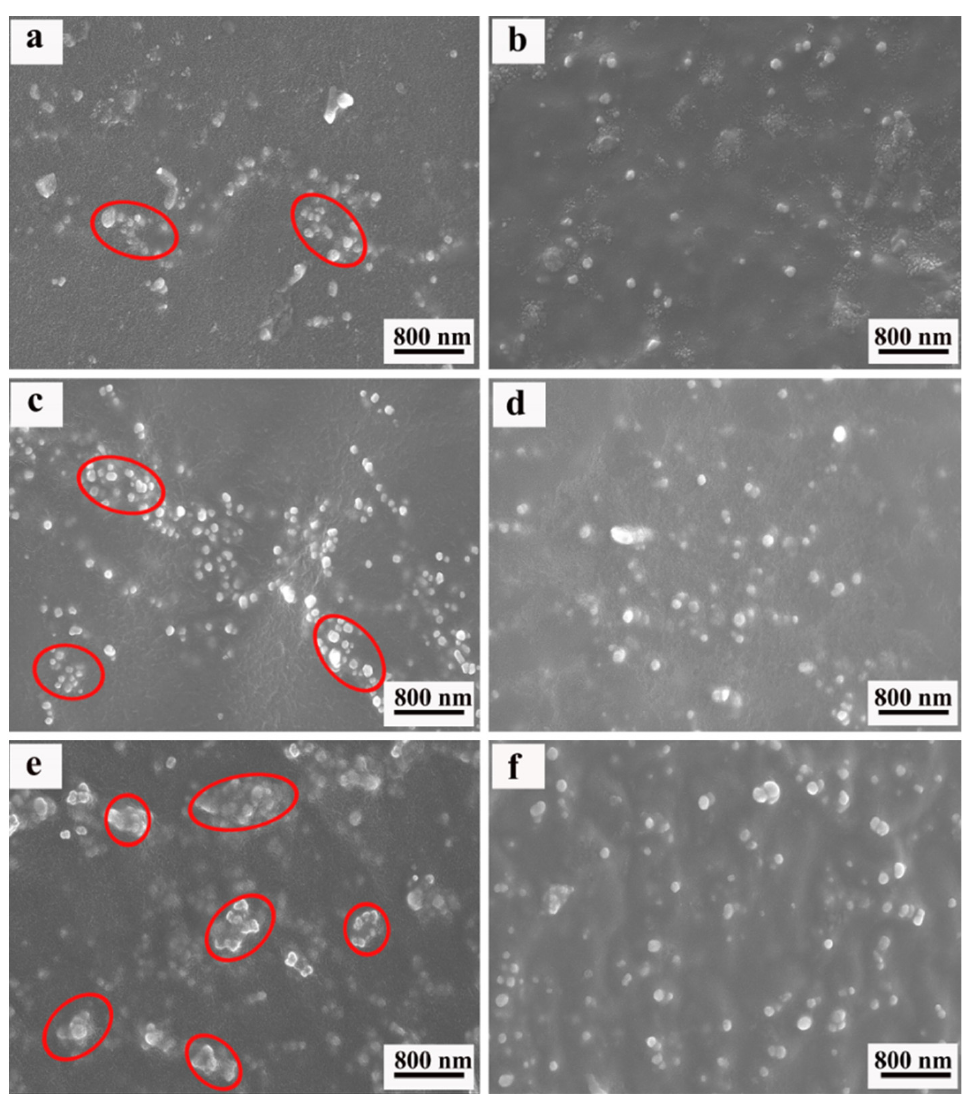
Figure 3. SEM micrographs of ENR composites. ( a ) 10 phr BTO/ENR, ( b ) 10 phr Si747@BTO/ENR,